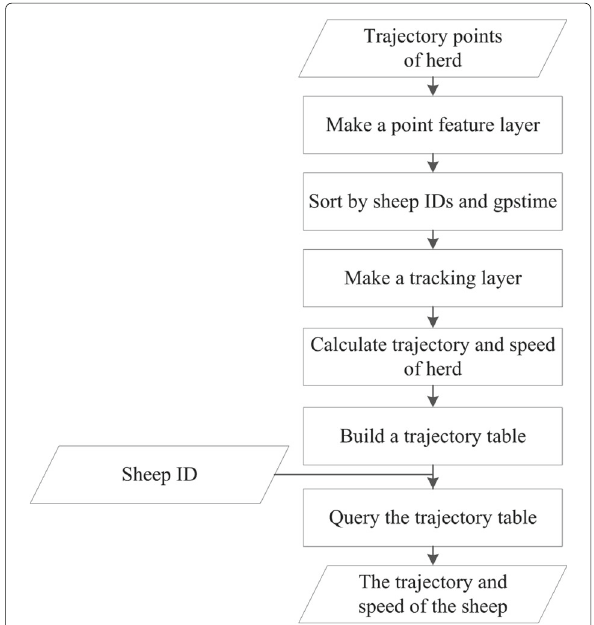
Fig. 5 Implementation flowchart of trajectory and speed